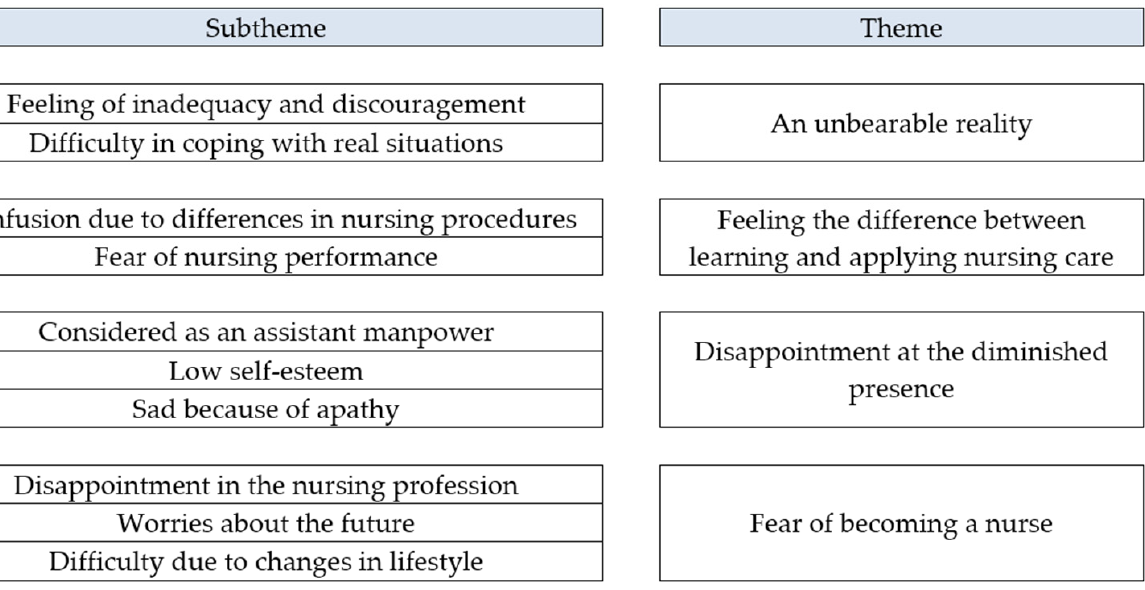
Figure 1. Research findings based on four main themes.